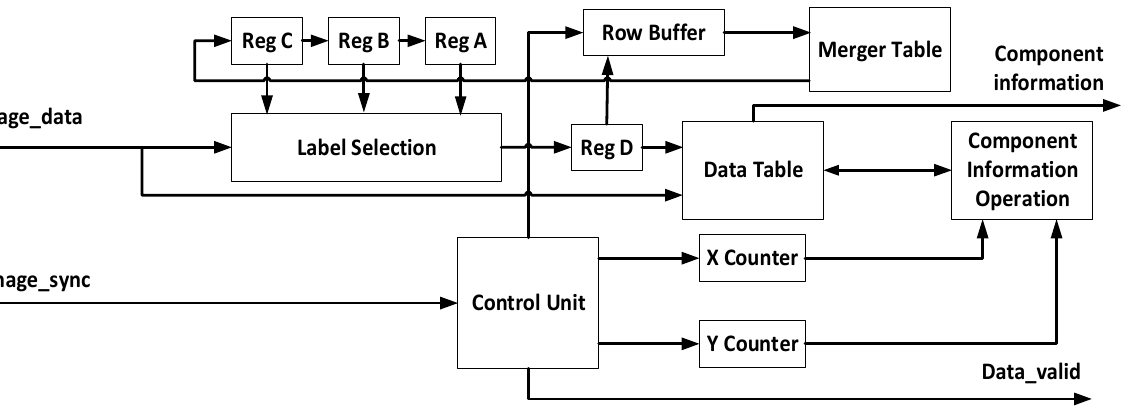
Figure 8. Hardware architecture of hand detection.